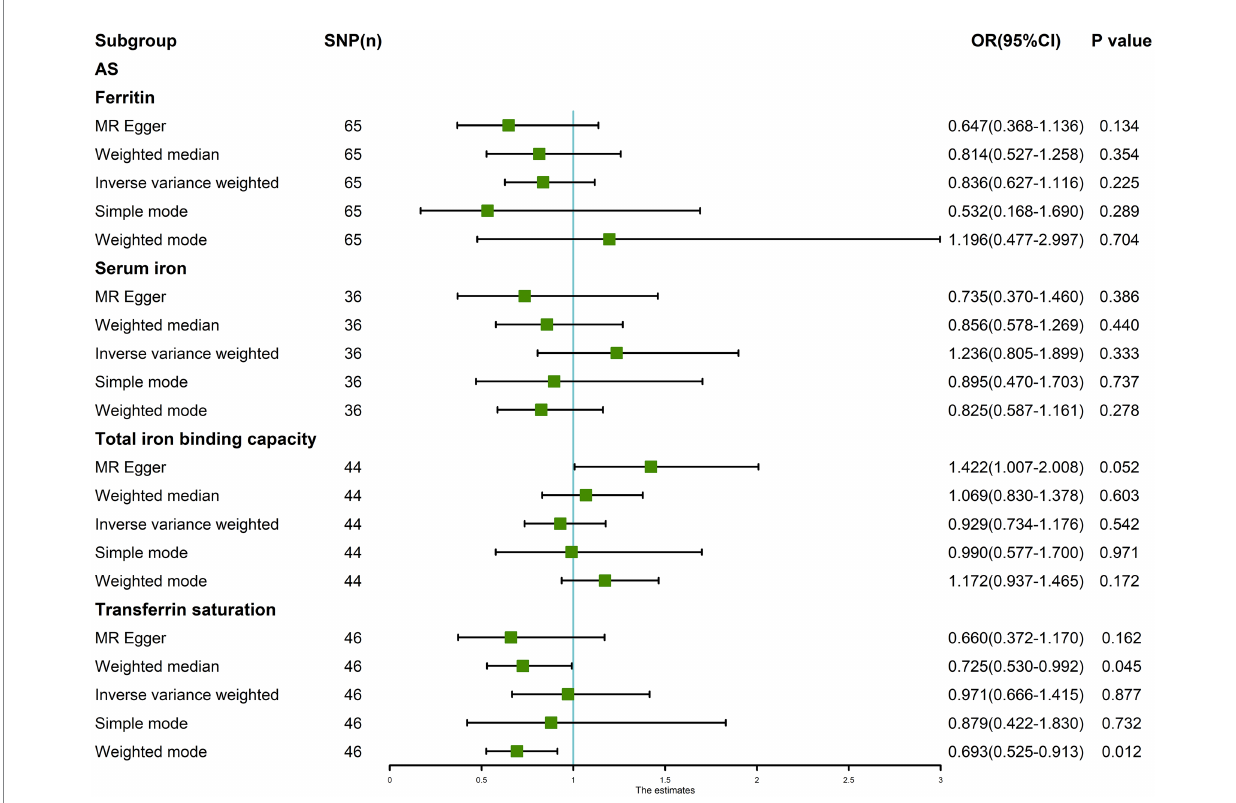
FIGURE 1 MR analysis results of the four exposures (ferritin, serum iron, total iron binding capacity, and transferrin saturation) and outcomes (ankylosing spondylitis). Five methods: random-effects IVW, MR Egger, weighted median, simple mode, and weighted